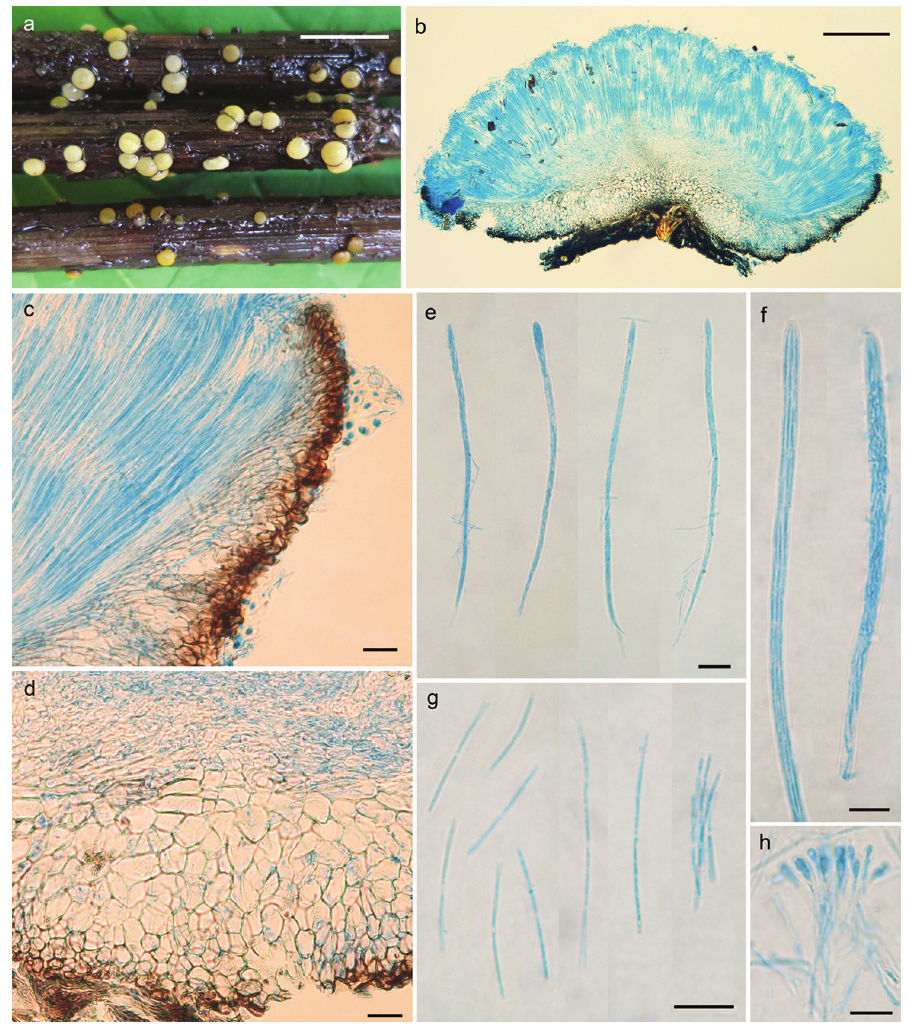
Figure 3. Vibrissea flavovirens (Pers.) Korf & J.R. Dixon (HMAS 275653). a Fresh apothecia on natu- ral substrate b Longitudinal section of apothecium c Structure of margin and upper flank d Excipular structure of lower part and near base e, f Asci g Fragments of ascospores h Paraphyses. Mouting medium: b–h lactophenol cotton blue. Scale bars: a = 5.0 mm, b = 200 μm, c–e = 20 μm, f–h = 10 Vibrissea flavovirens (Pers.) Korf & J.R. Dixon, Mycotaxon 1(2): 134, 1974.